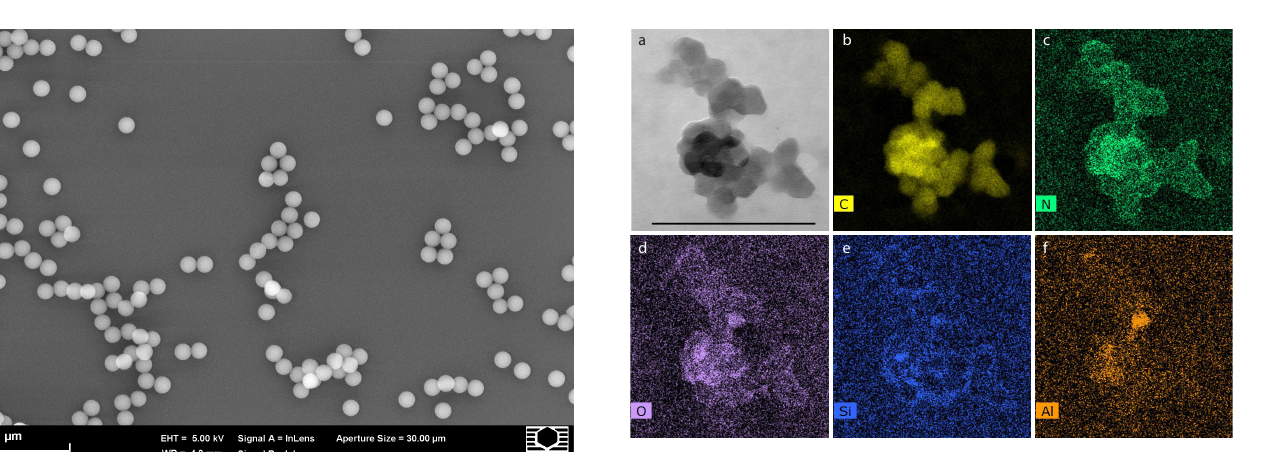
Figure 4. An example of a BC aggregate with nitrogen and oxy- gen coating and aluminum-rich silicate inclusions from Law Dome, Antarctica ice core dated to 1759CE. (a) STEM image, scale bar = 300nm. (b–f) a series of STEM EDS maps for C, N, O, Si and Al, respectively. Element maps shown are from same field of view as image (a) .